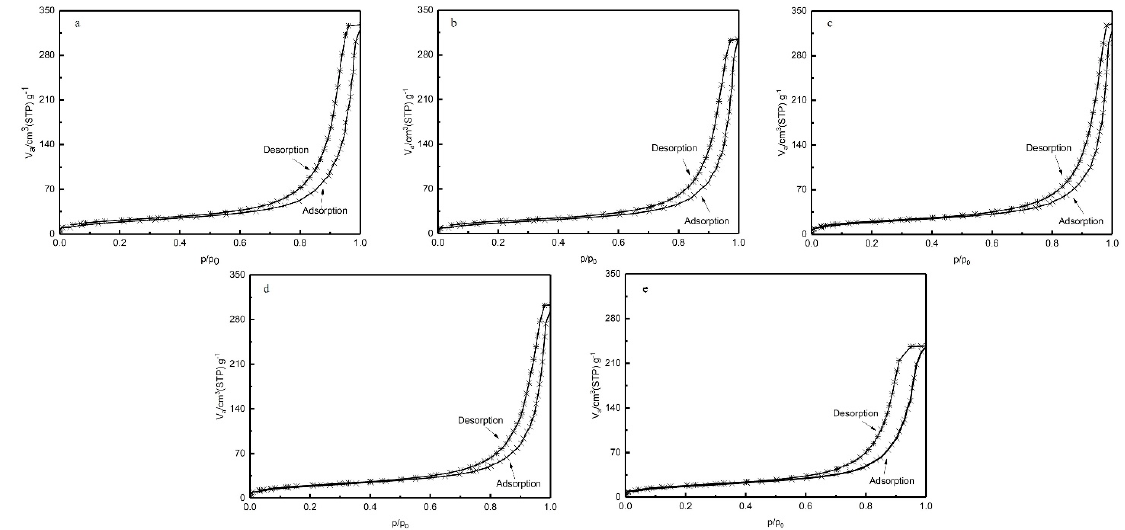
Figure 9. Isotherm of nitrogen adsorption–desorption for the porous PEEK hollow fiber ( a : 240 °C; b : 250 °C; c : 260 °C; d : 270 °C; e : 280 °C).